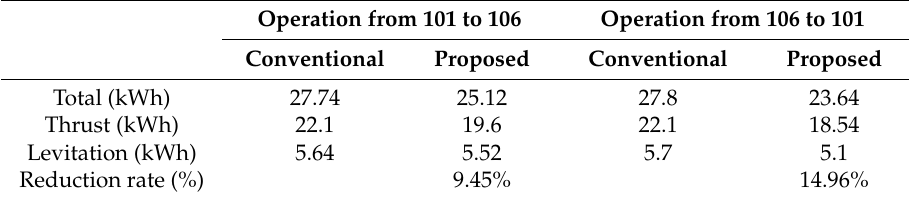
Table 4. Comparison of power-consumption